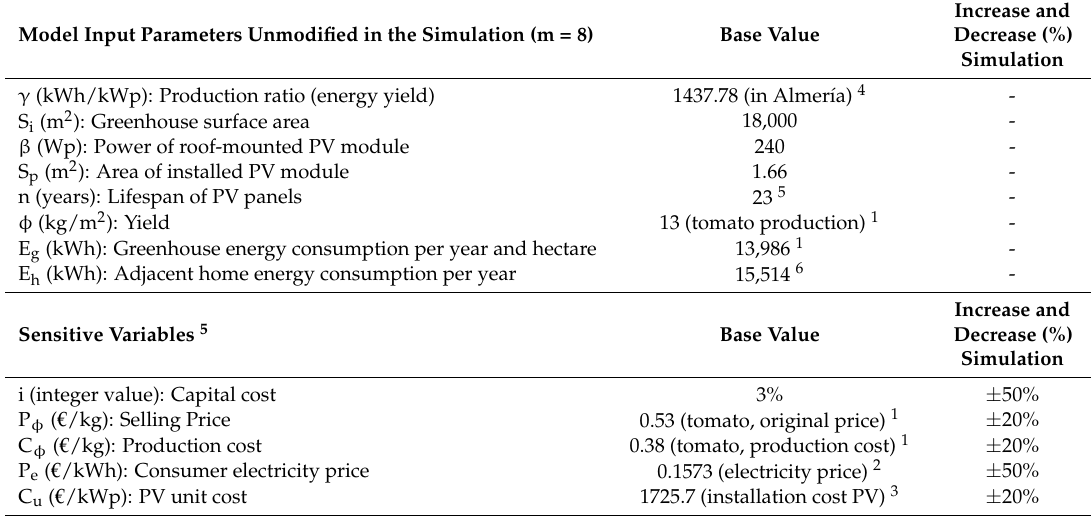
Table 1. Base values of sensitivity